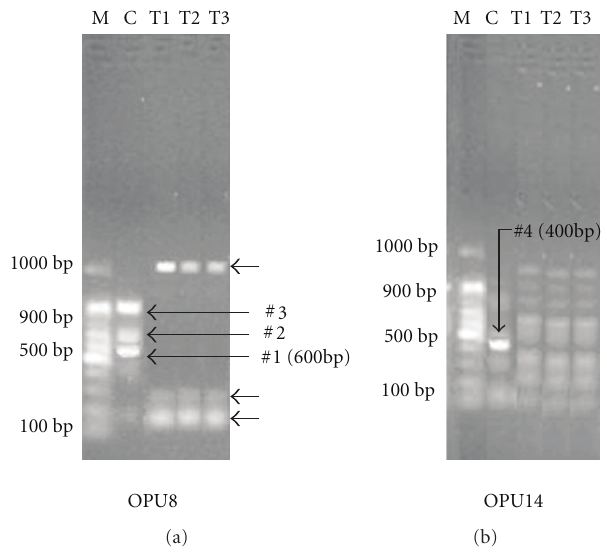
Figure 3: Representative RAPD profiles showing DNA fingerprint patterns with DNA from 3 of 15 polluted amniotic liquid-treated ( T ) and 1 of the 15 non-polluted amniotic liquid-treated sea urchin embryos (C). Arrows indicate gains/losses di ff erences for amplification products and the size of the amplified fragments (bp). Primers used (OPU8 and OPU14) are indicated at the bottom of each set of fingerprints. M, DNA molecular size marker, 100bp